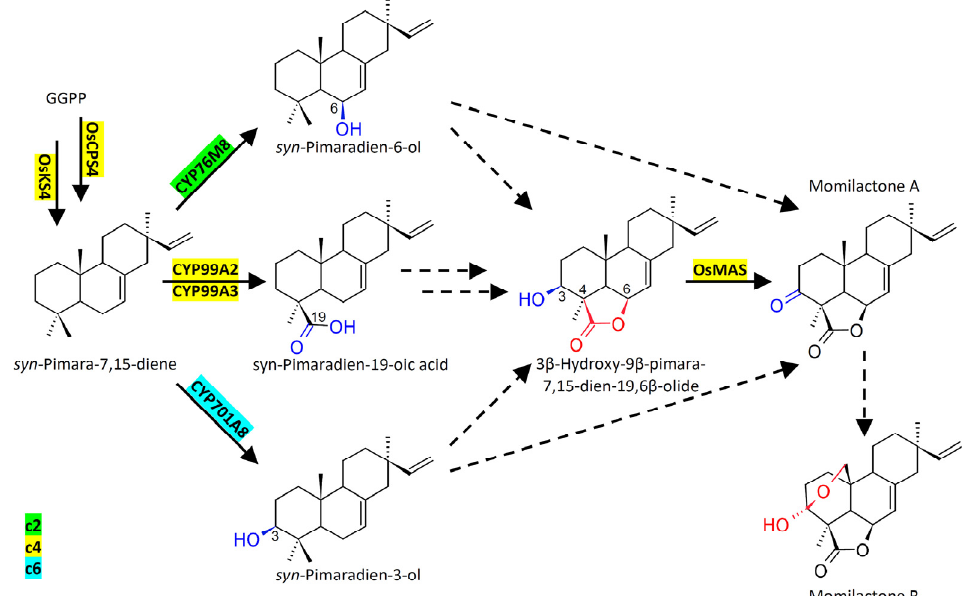
Figure 8. Proposed pathway for the biosynthesis of momilactones A and B. Chemical functions in blue indicate characterized reactions, while predicted functionalities are indicated in red. Dashed arrows indicate missing steps. Enzymes encoded by genes on chromosome 2, 4, and 6 (c2, c4, c6) are highlighted in green, yellow, and blue, respectively. GGPP: geranyl geranyl diphosphate; OsMAS: rice momilactone A synthase; OsKS4 (OsKSL4): syn -pimara-7,15-diene synthase (EC 4.2.3.35); OsCPS4 (OsCyc1): syn -copalyl diphosphate synthase (EC 5.5.1.14); CYP76M8: oryzalexin D synthase (EC 1.14.14.112; 1.14.14.123); CYP99A3: 9-beta-pimara-7,15-diene oxidase (EC 1.14.14.111); CYP99A2: cytochrome P450 99A2 (EC 1.14.-.-); CYP701A8: ent -sandaracopimaradiene 3-hydrox- ylase (EC 1.14.14.70) (adapted from [128]).